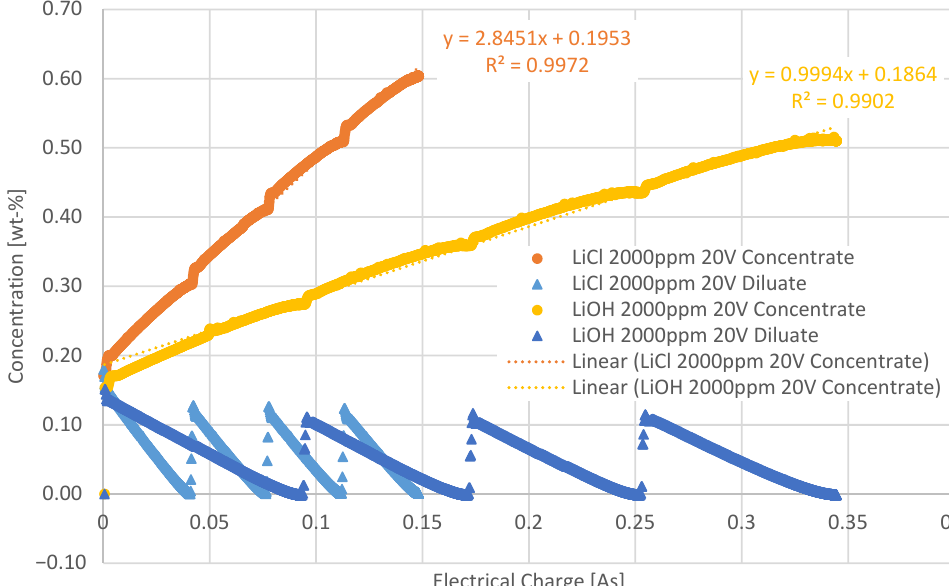
Figure 6. Comparison of experiments using initial concentrations of 2 g/L of the LiCl and LiOH solutions, respectively, at 20 V, as a function of the electrical charge at ϑ = 21 °C. Again, the slope of the solution with LiCl is steeper and the transport through the membrane seems better. The CEs support this trend, with the overall CE for the 2 g/L LiCl solution at 61.3% and the 2 g/L LiOH solution at 41.1%. While the concentration increase